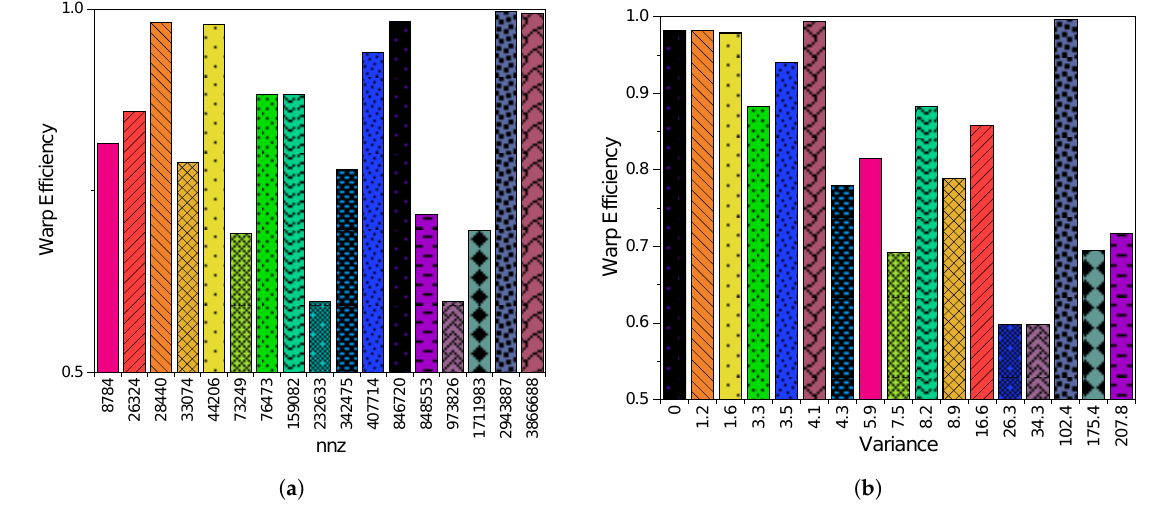
Figure 15. HYB warp efficiency against: ( a ) nnz and ( b ) npr variance